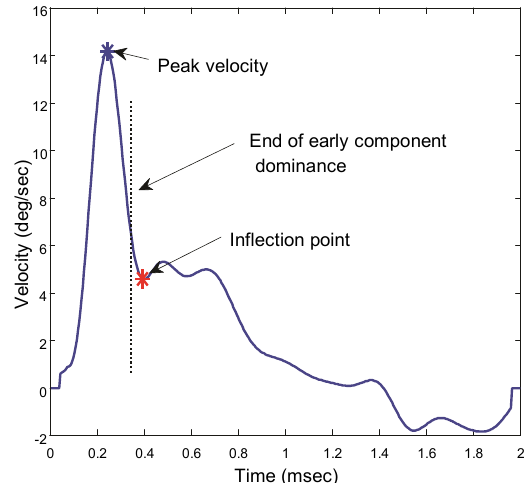
Figure 3: Velocity traces showing the point taken as an inflection and the assumed boundary between the initial and slow component dominant segments. The slow component is taken from this point until the end of the 2.0 sec response. All responses in all subjects showed an inflection point in the velocity